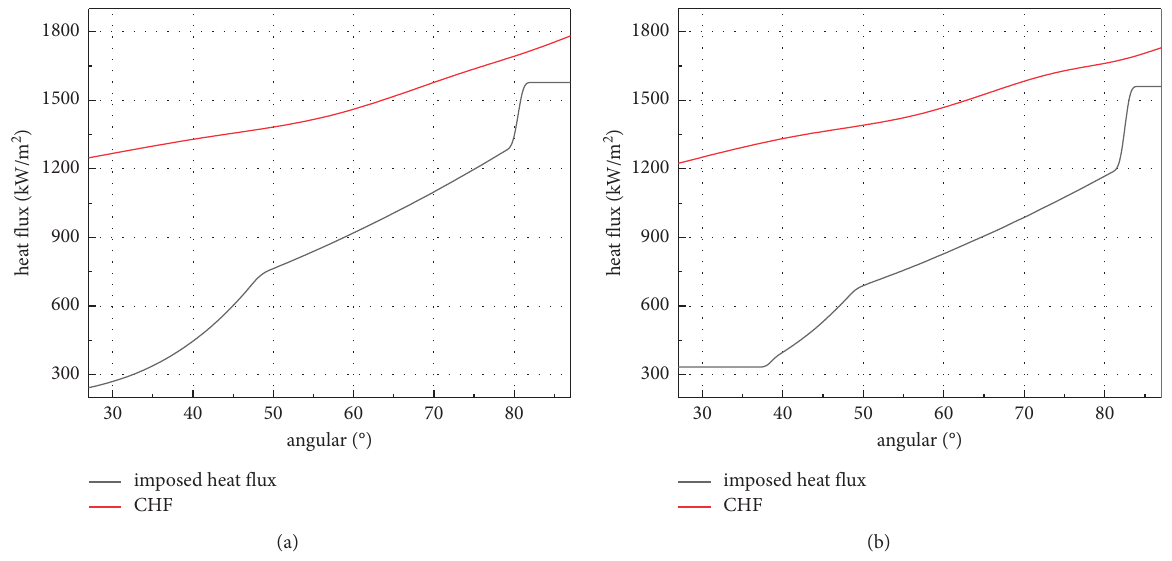
Figure 14: CHF compared with imposed heat flux in tests 1 and 4. (a) Two-layer. (b) Three-layer.